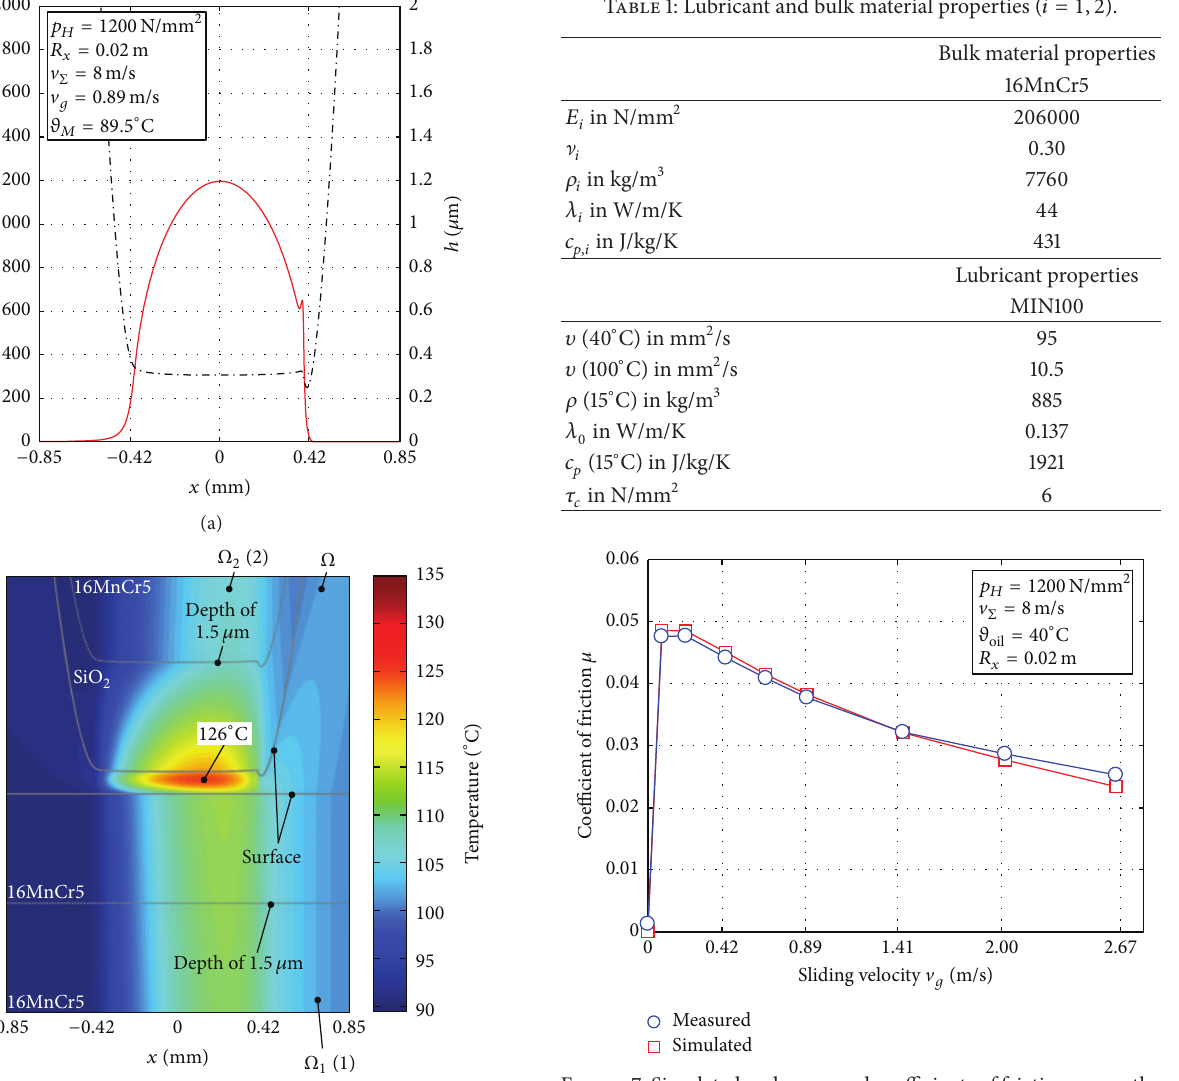
Figure 7: Simulated and measured coefficients of friction 𝜇 over the sliding velocity V 𝑔